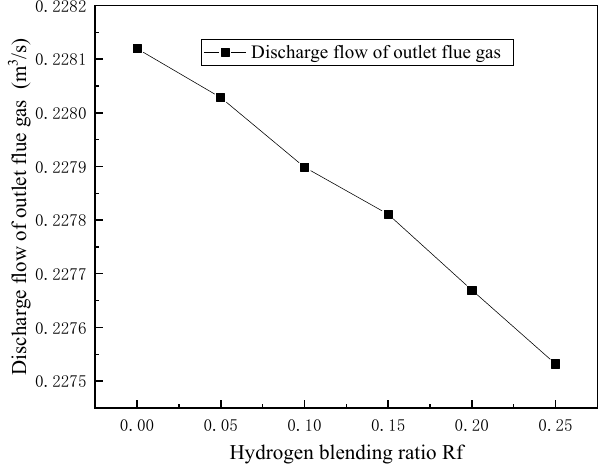
Figure 11. Discharge flow of outlet flue